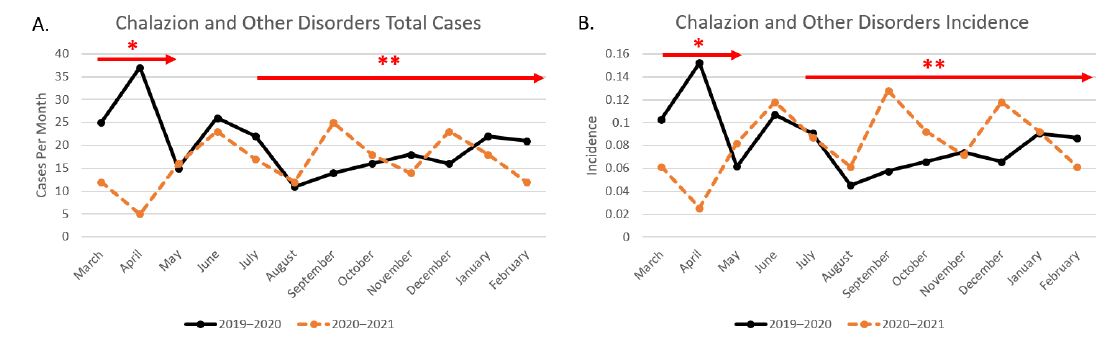
Figure 1. Total chalazion and other disorders cases including university lockdown and state mask mandate labels. Figure 1 shows the pre-pandemic versus mid-pandemic total cases per month ( A ) as well as the incidence ( B ). * Months during which the academic center was under lockdown (March 2019–early May 2019). ** Months during which Texas mask mandate was effective (July